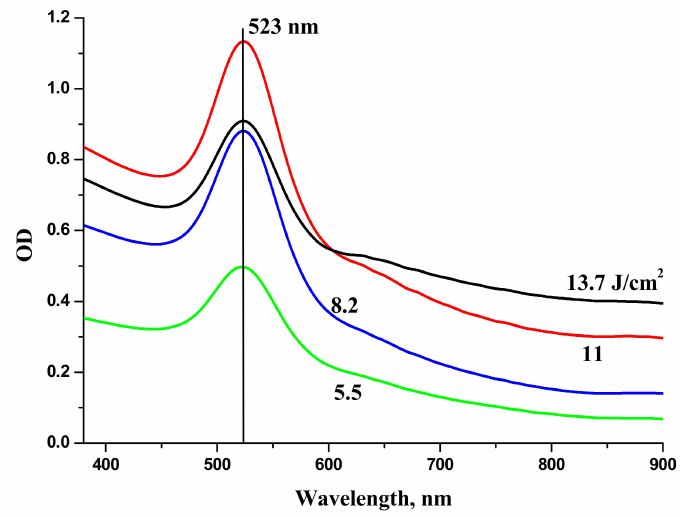
Figure 6. Extinction spectra of Au NPs generated by ablation of Au target with pulse duration 200 ns in H 2 O with various fluences on the target surface. Laser fluence on the target is indicated at each spectrum. Copied from reference [25] with copyright permission from Journal of Physics of Wave Phenomena Springer